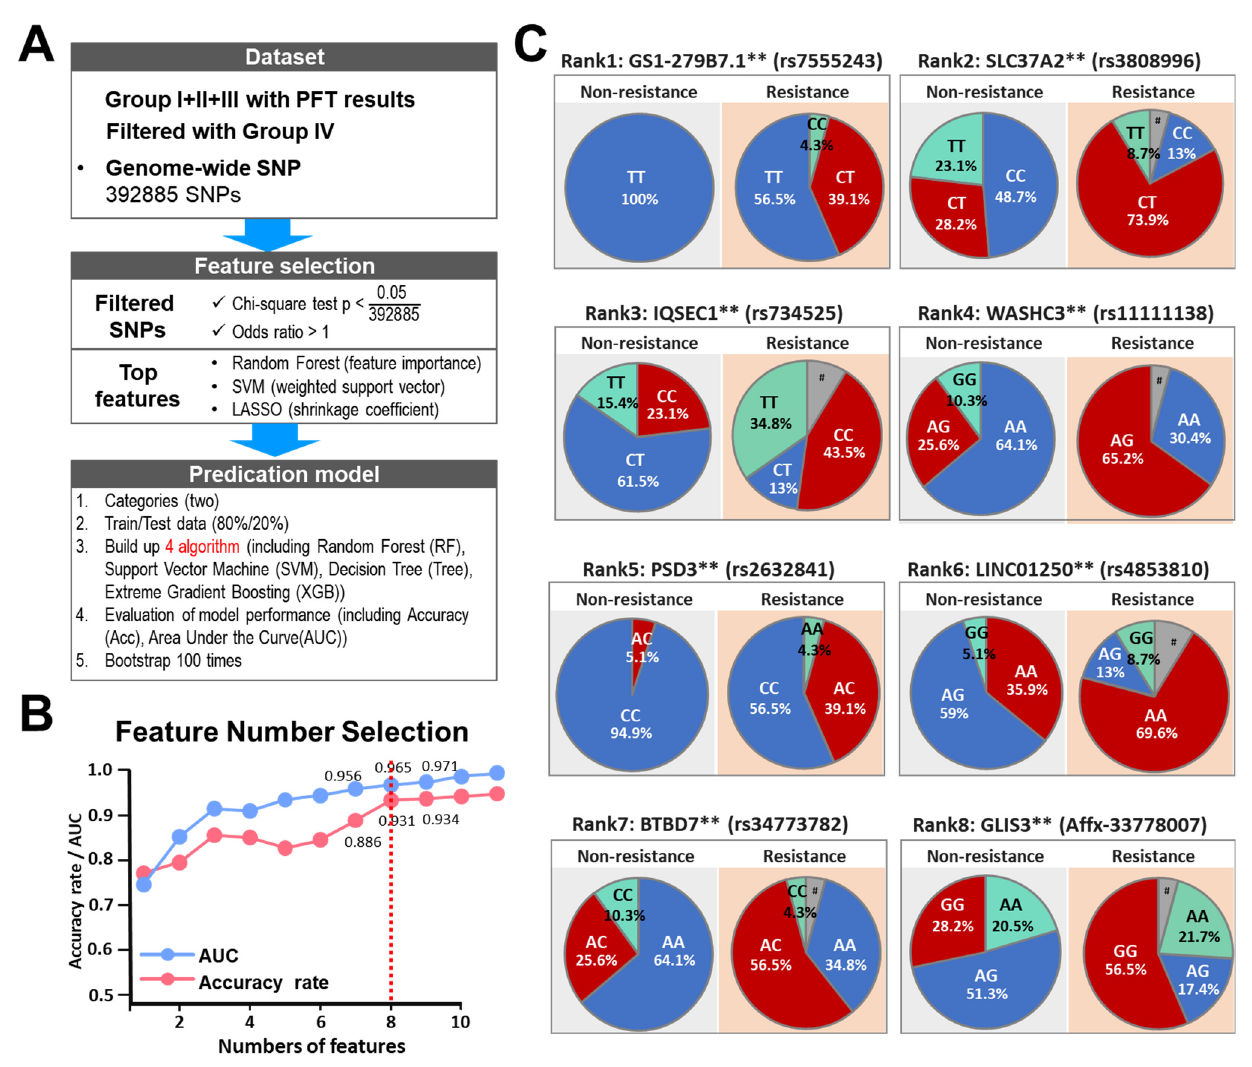
Figure 4. Prediction models built based on clinical features and genome-wide SNPs to classify clopidogrel-resistant patients using machine learning methods. ( A ) Machine learning workflow to select reliable and predictable features to build prediction models for group classification. ( B ) Accuracy and AUC of SVM model with different feature selection numbers. ( C ) Pie charts indicating the genotype frequencies of SNPs identified by AI-assisted analysis using SNP datasets obtained from patients of the four groups. # indicates the signaling of SNP array was lower than the calling rate. ** p < 0.005 by Chi-square test. # indicates that the signaling by the SNP array was lower than the calling rate. GS1-279B7.1 is annotated as a pseudogene. SLC37A2, Solute Carrier Family 37 Mem-